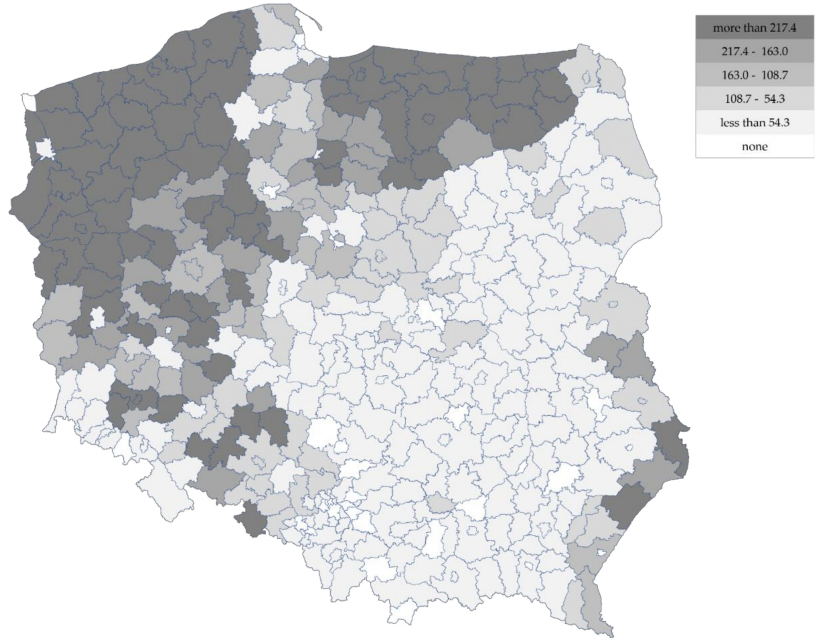
Figure 2. Number of flats sold from state-owned farm resources per 10,000 total population ( W 1 ) in poviats. Source: The authors’ calculations based on data of: KOWR and GUS.